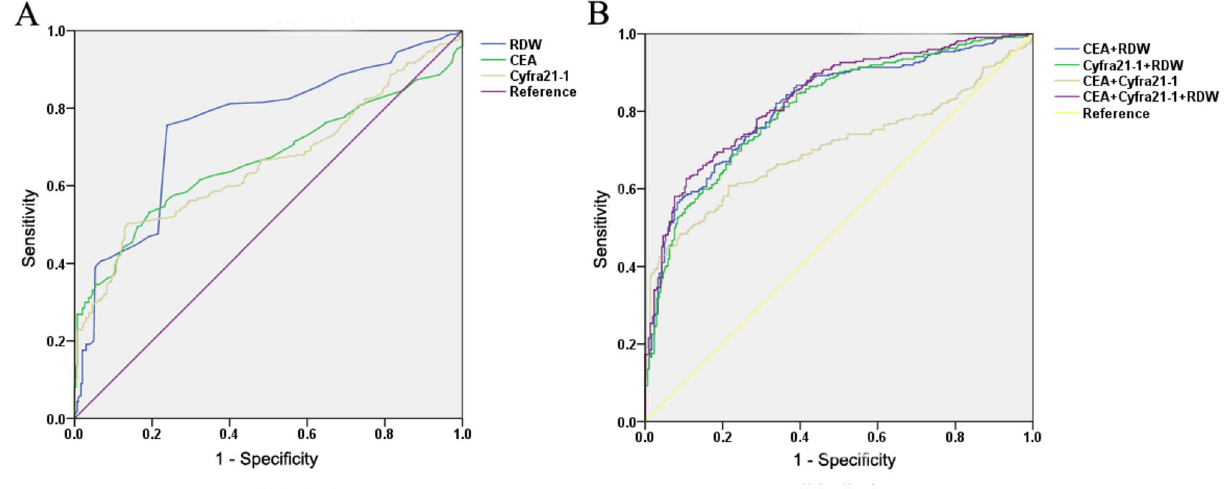
Figure 2. ROC analysis based on RDW for NSCLC diagnosis. ( A ) ROC analysis of value of RDW alone, CEA alone, and Cyfra21-1 alone for NSCLC diagnosis. ( B ) ROC analysis of value of combined detecting RDW, CEA and Cyfra21-1 for NSCLC diagnosis.